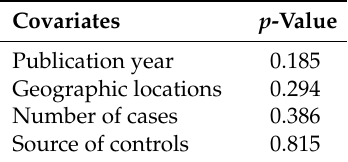
Table A1. The detailed results for the covariates by univariate